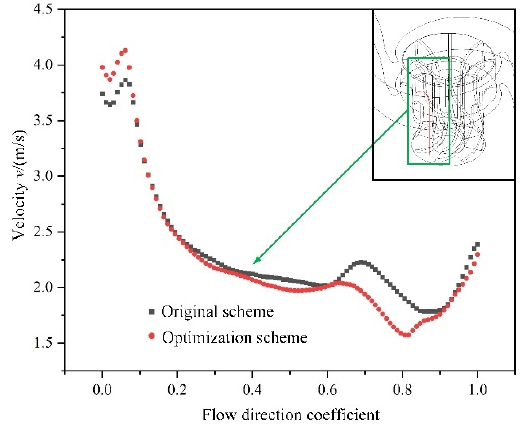
Figure 11. Streamline distribution of radial blades of compound impeller before and after optimiza- tion: ( a ) original scheme and ( b ) optimization scheme.